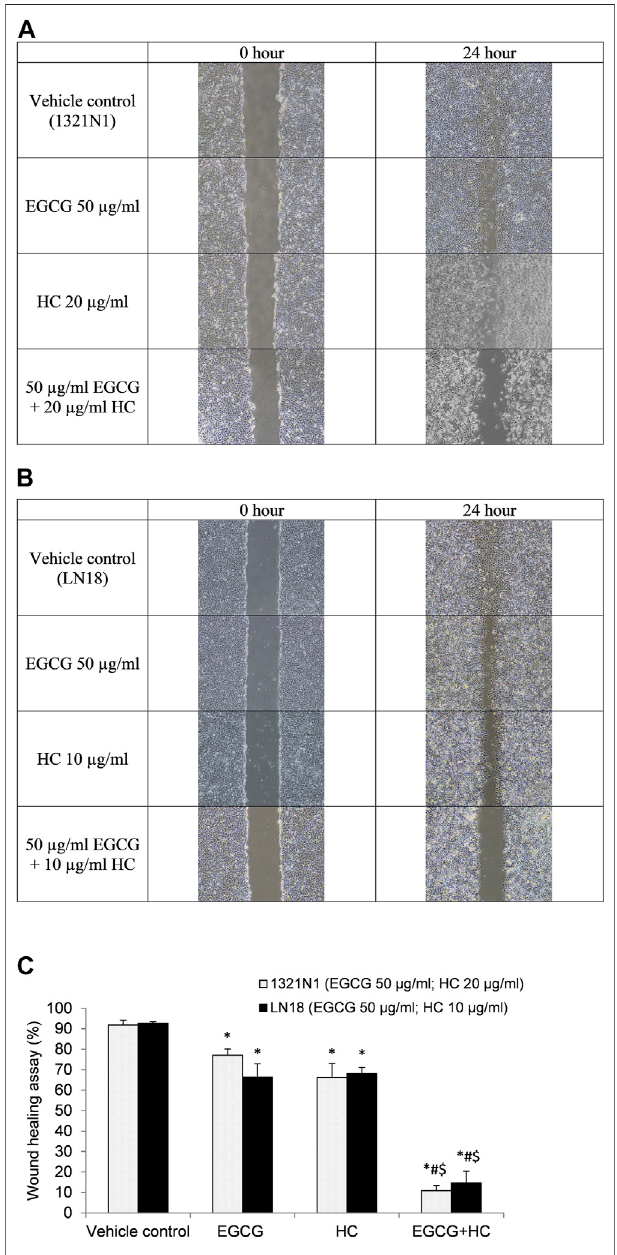
FIGURE 7 | Wound healing assay. The photo was taken at 0- and 24-h following the scratch test. (A) 1321N1 cells were treated for 24-h 50 μ g/ml EGCG, 20 μ g/ml HC, or EGCG+HC, and (B) LN18 cells were treated for 24-h with 50 μ g/ml EGCG, 10 μ g/ml HC, or EGCG+HC. (C) The percentage of wound healing closure (%) of 1321N1 and LN18 treated with EGCG, HC, and EGCG+HC. * p < 0.05 compare to control, # p < 0.05 compare to EGCG, $ p < 0.05 compare to